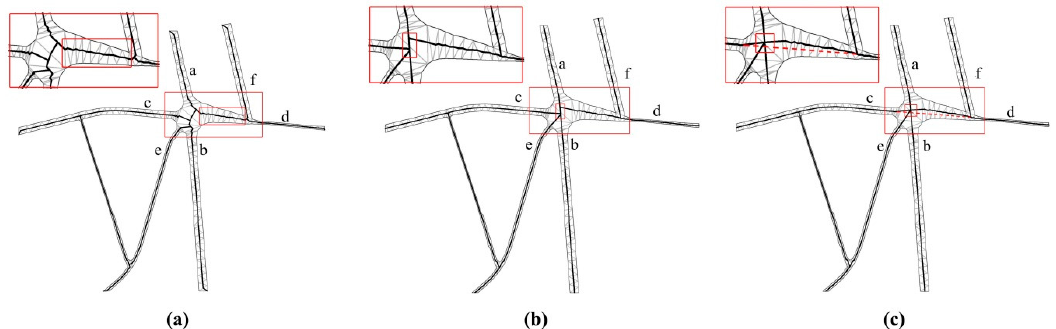
Figure 15. Case 1: Branch junctions with a consistent direction skeleton: ( a ) original skeleton lines, ( b ) split line extracted from skeleton lines considering direction features and ( c ) re-aggregation of the split lines in the branch junction.